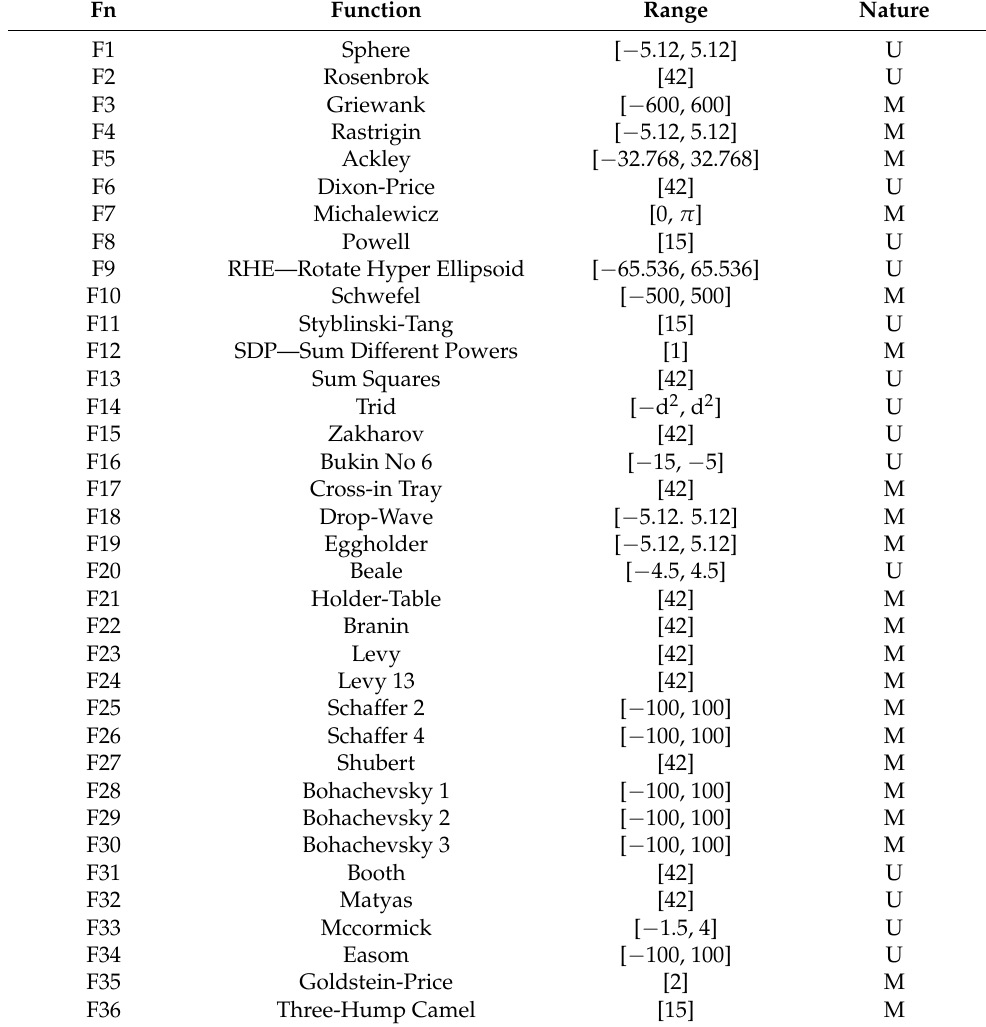
Table 3. 36 Mathematical Functions